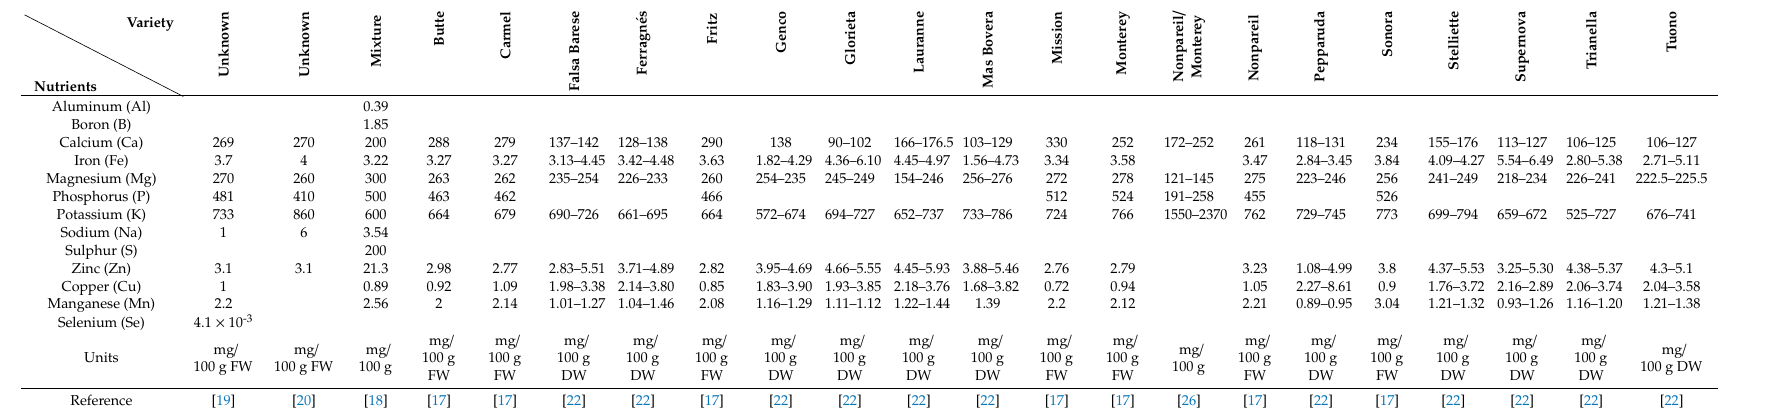
Table 2. Mineral composition (mg / 100 g) of di ff erent varieties of almonds ( Prunus dulcis Mill. D. A.